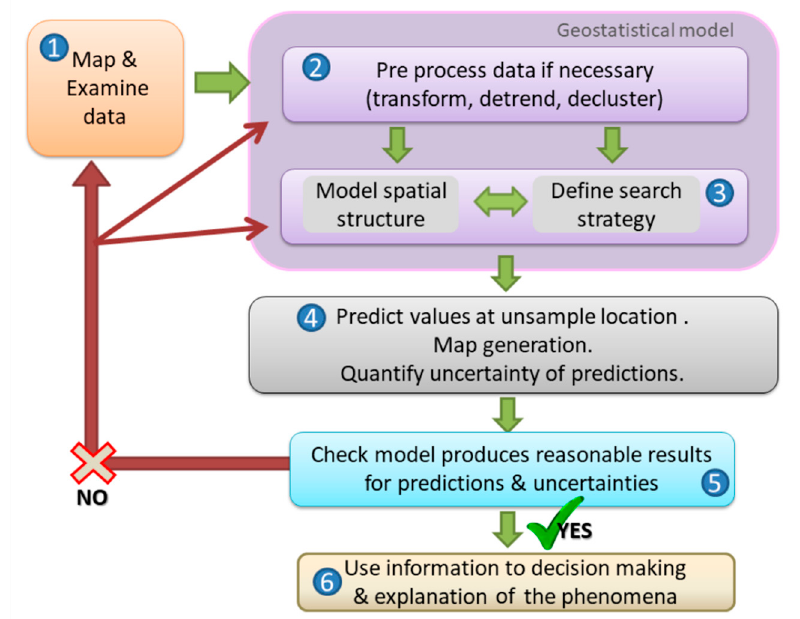
Figure 1. Six steps workflow (modified from ESRI ArcGIS Pro) to build and to evaluate geostatistical models for spatial studies using ArcGIS 10.4.1 (ESRI, Inc.). The different steps involve the data examination, the parameter definition to structure the model strategy, the prediction, and the evaluation, resulting in an optimized model to explain the phenomena. If the resulted model is a non-precise, the process should be iterated at data examination and selection (step 1) or by restructuring the model (steps 2 and 3). Detailed configurations for each step are given in Figure 2.